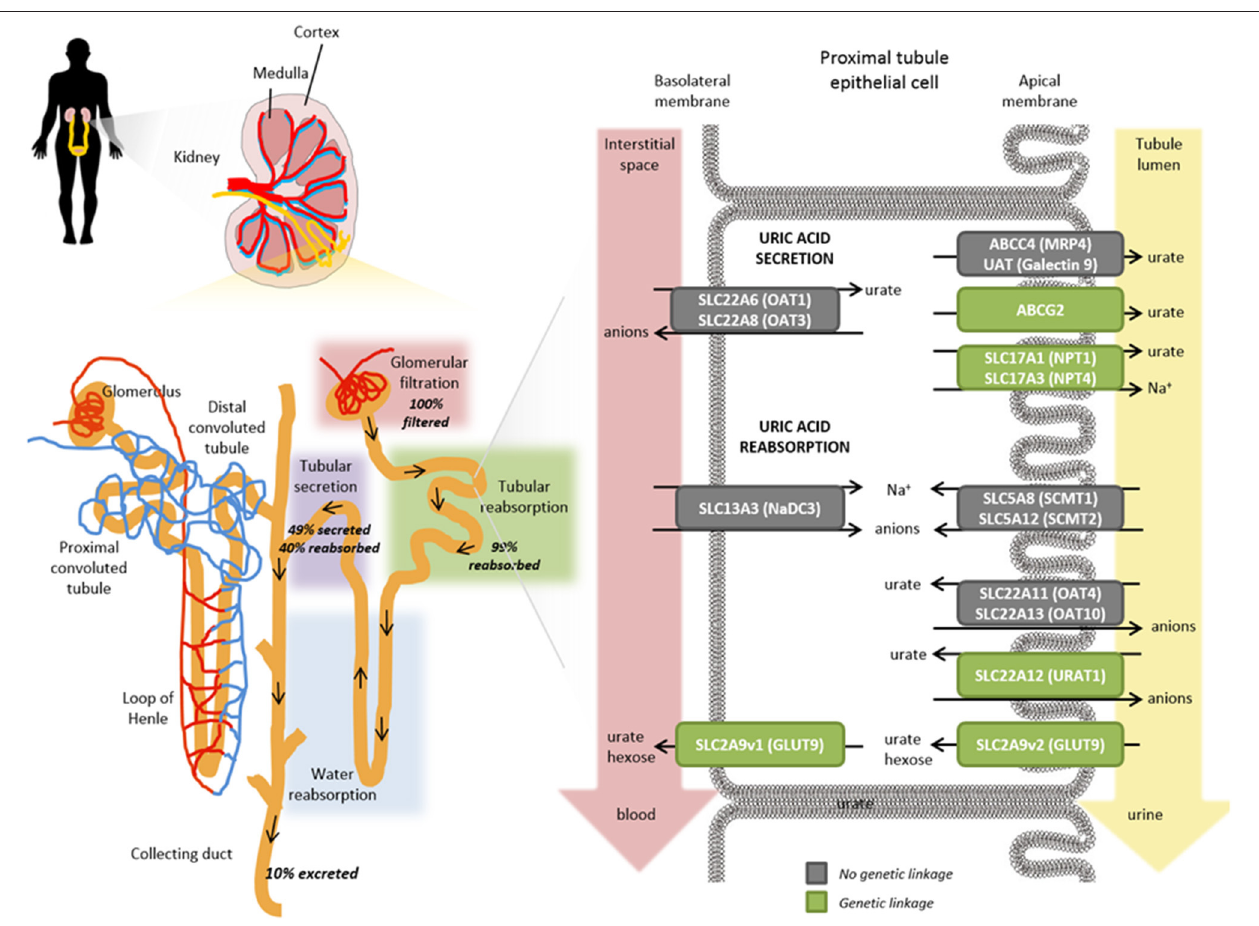
FIGURE 4 | Role of transporters in the renal proximal tubule on urate handling. Within an individual nephron in the kidney (yellow), filtration of water and solutes occurs in the glomerular capsule from the afferent arteriole into the renal tubule (pink shading). Tubular reabsorption (green shading) is predominantly mediated by the proximal convoluted tubule whereas tubular secretion extracts uric acid (and other substances) from peritubular capillaries (purple shading) and secretes them into the tubular fluid for urinary excretion. Urate transporters in renal proximal tubule epithelial cells actively mediate the secretion and reabsorption of urate. The balance between these processes determines the net excretion levels from the kidney. The anion transporters SLC22A6 (OAT1) and SLC22A8 (OAT3) localized on the basolateral membranes transport urate from the interstitial space in the blood depending on the gradients for exchanged anions but have not been shown to exhibit a genetic linkage with hyperuricemia or gout risk (gray box). On the apical membrane, ABCG2, SLC17A1 (NPT1), SLC17A3 (NPT4), ABCC4 (MRP4), UAT (Galectin 9) have all been shown to contribute to the secretory transport of urate into the tubule lumen and leading to urinary excretion; a number of these have been genetically associated with hyperuricemia and gout risk (green boxes). Exchange gradients upstream of urate anion exchange are enabled through the actions of SLC13A3 (NaD3), SLC5A8 (SCMT1), and SLC5A12 (SCMT2). In renal reabsorption, the apical urate-anion exchanger SLC22A12 (URAT1) has been shown to play a predominant role in urate homeostasis and indeed several variants have been identified to be associated with gout and hyperuricemia risk (green box). Additional contributions to urate reabsorption are mediated by SLC22A11 (OAT4) and SLC22A11 (OAT10) (gray boxes, not genetically associated with gout/hyperuricemia risk) and the short isoform of SLC2A9v2 (GLUT9, green box) on the apical membrane. The long isoform of SLC2A9v1 (GLUT9, green box) is the only known transporter to mediate basolateral efflux of urate back into circulation; which is in accordance with its genetic association for gout and hyperuricemia risk in addition to rare mutations associated with